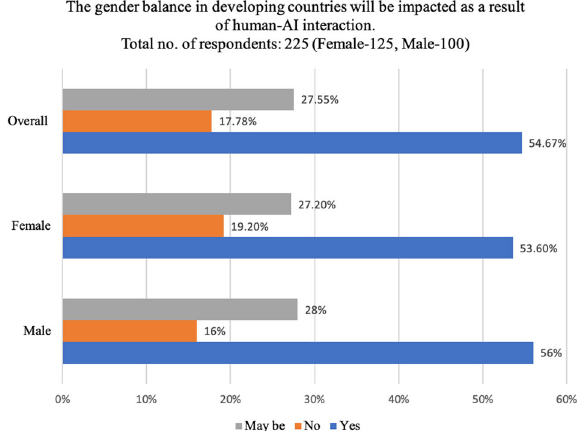
Fig. 3 The gender balance in developing countries will be impacted as a result of human – AI interaction. Total no. of respondents: 225 (Female: 125, Male: 100).